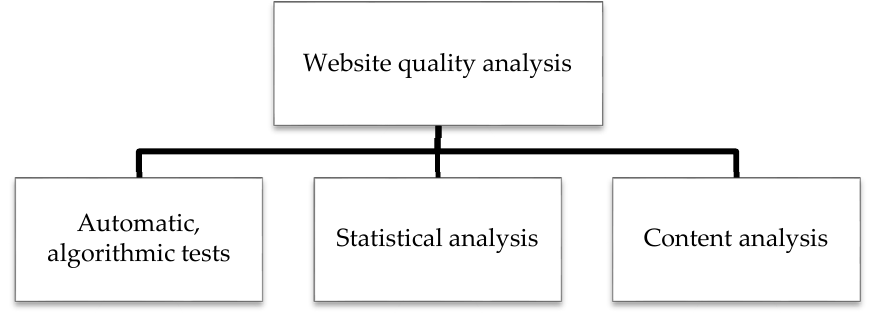
Figure 2. Stages of the research process. Source: original work.